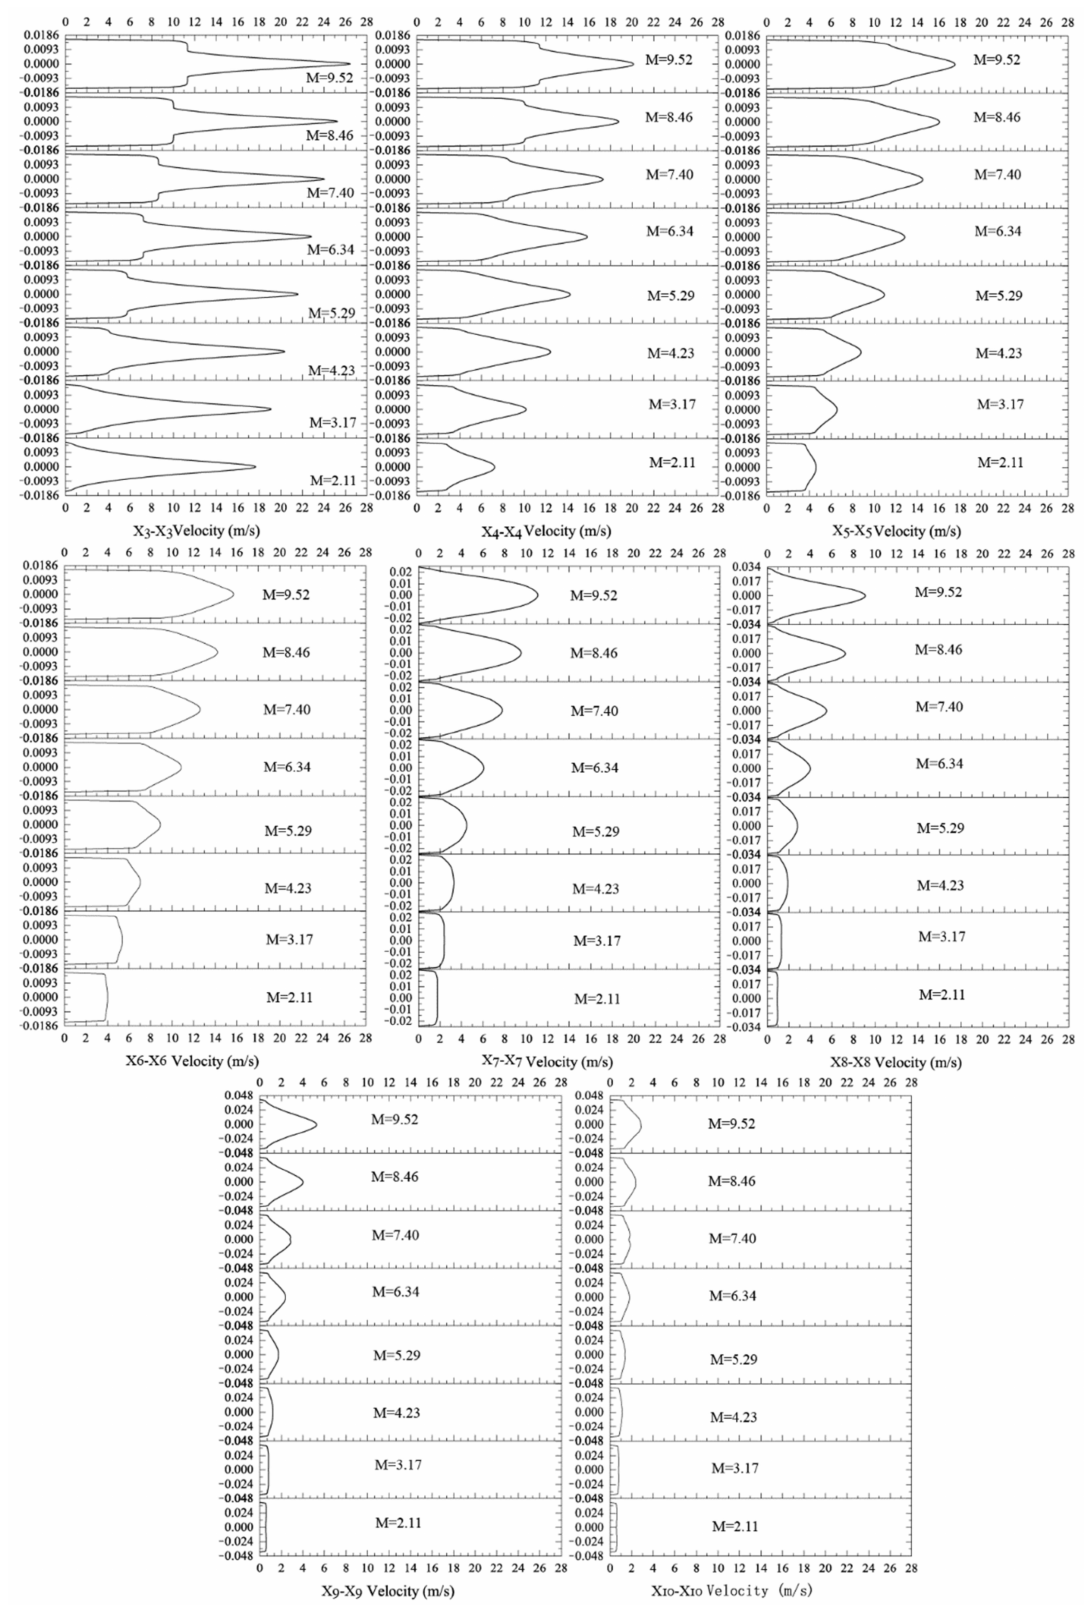
Figure 13. Velocity profile of cross-sections X 3 -X 3 ~X 10 -X 10 ( M = 2.11, 3.17, 4.23, 5.29, 6.34, 7.40, 8.46,